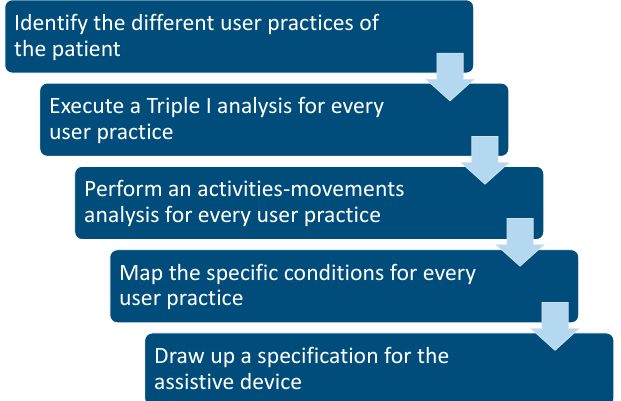
Figure 3. Graphical representation of the Triple-I methodology for user practices to set up the specifications for the assistive device.